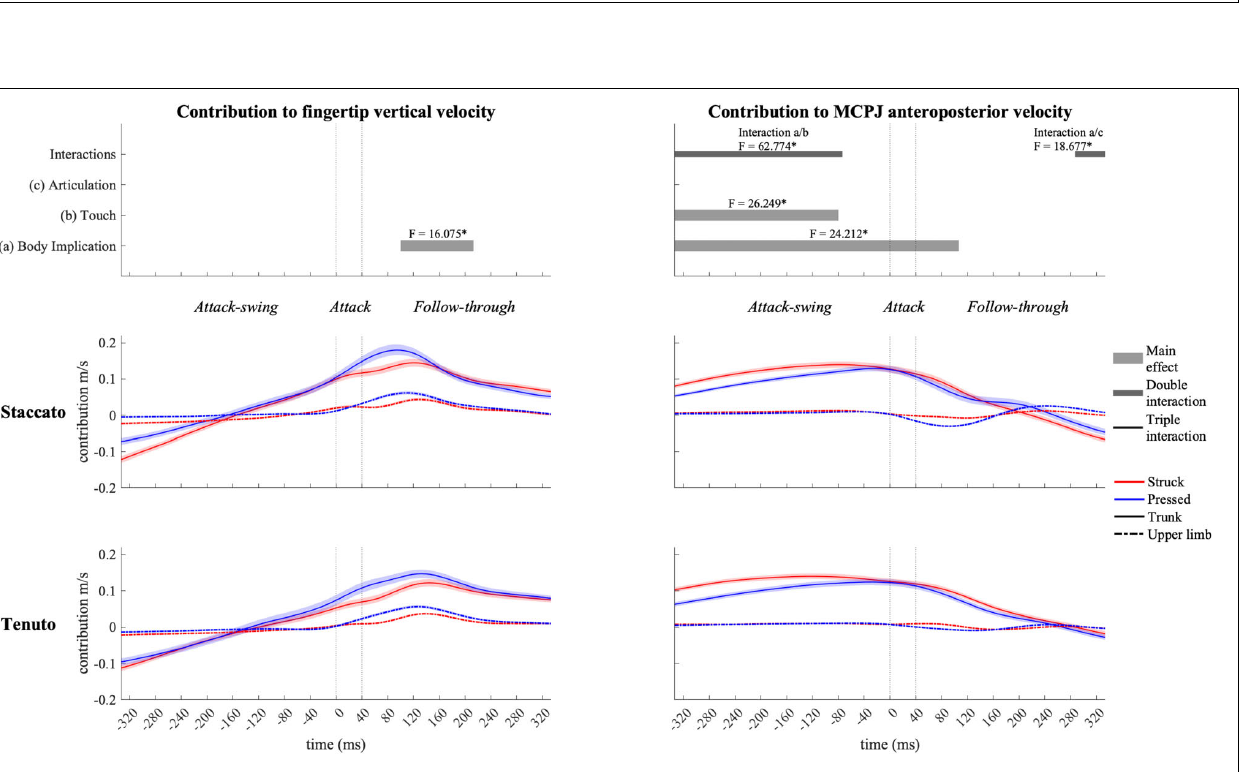
FIGURE 9 | Mean values (solid and dash-dotted lines) and 95% bootstrap confidence interval (shaded areas) of pelvo-thoracic joint angular contribution to endpoint velocities during the three phases of the keystroke. Negative/positive values indicate contributions to downward/upward fingertip velocities and to backward/forward metacarpophalangeal joint (MCPJ) velocities. Top panels represent the results from the statistical parametric mapping of time-series values. * p -value ≤ 0.001.